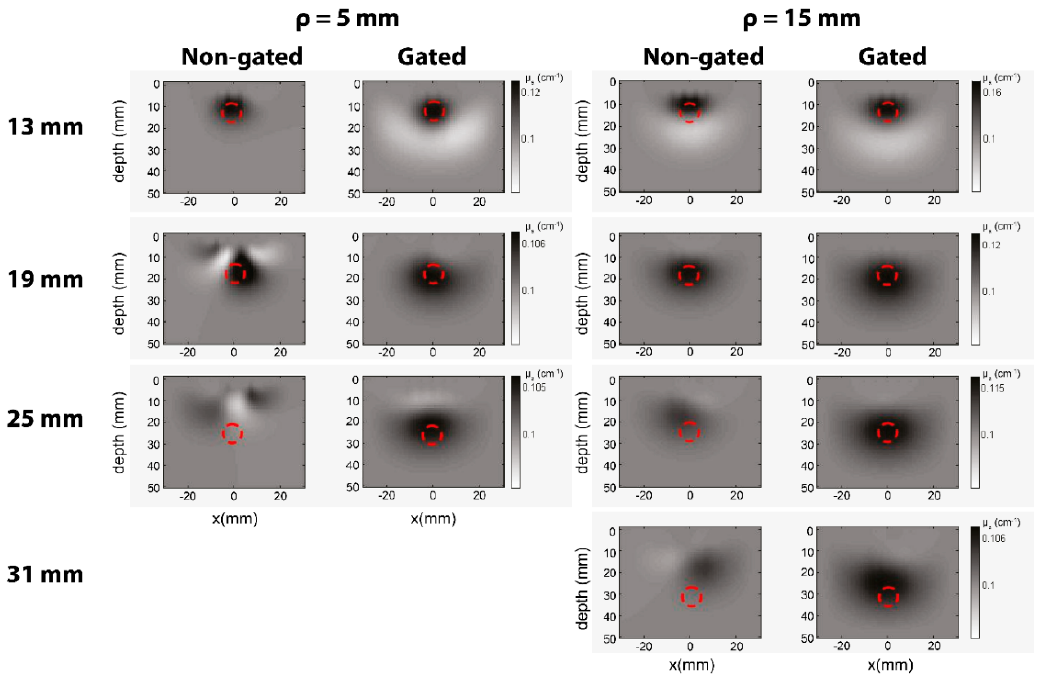
Figure 13. 2D maps of an inclusion ( Δ μ a = 0.5 cm − 1 ) buried at different depths (rows) inside a homogeneous medium (optical properties: μ a = 0.1 cm − 1 and μ s ’ = 10 cm − 1 ) obtained using non-gated and gated approaches for both 5 and 15 mm ρ . The red circle represents the true position of the inclusion. Dimensions of the plane are in mm. For more depths and the geometry of the maps, see Ref. [143].